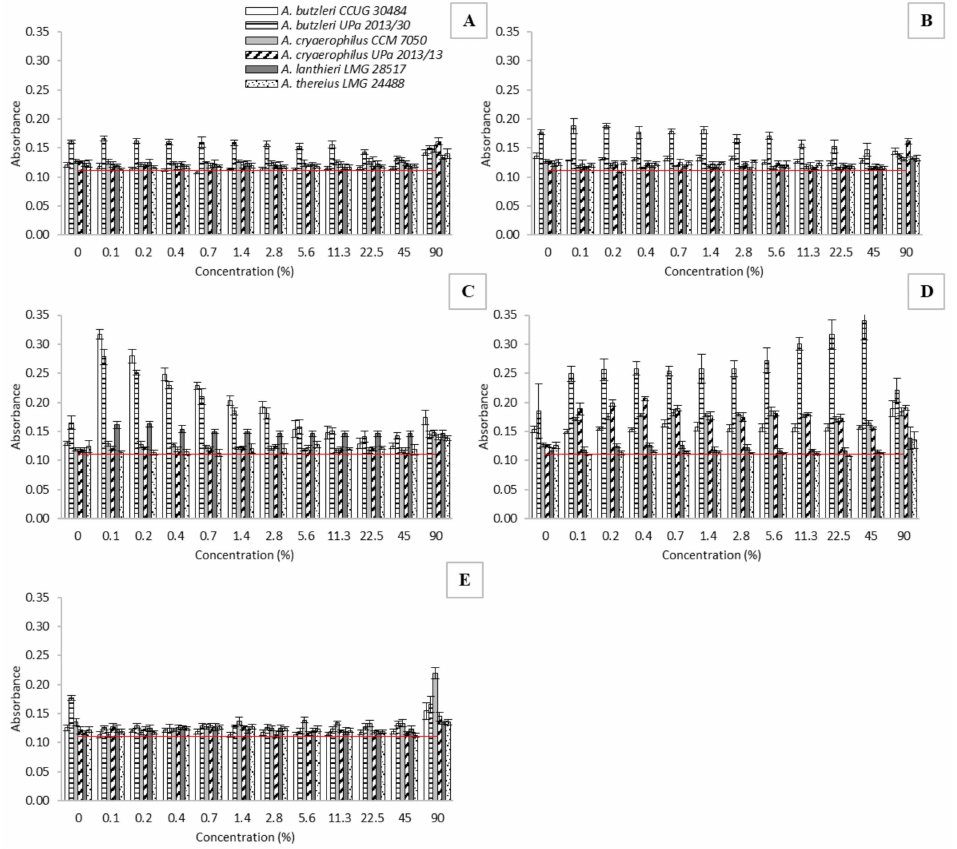
Figure 4. Biofilm formation in the presence of BEOO at a concentration of 90%. ( A )—extra virgin olive oil (Ballester); ( B )—extra virgin olive oil (Kyosos); ( C )—blended sunflower and extra-virgin olive oil (Ondoliva); ( D )—pure olive oil (Borges); ( E )—olive pomace oil (Ondoliva). The horizontal red line represents the influence of BHI broth (values under horizontal line—biofilm negative; values above line—biofilm positive). The results are presented as a mean ± standard deviation. Statistical significance between the groups was assessed by ANOVA at 5%